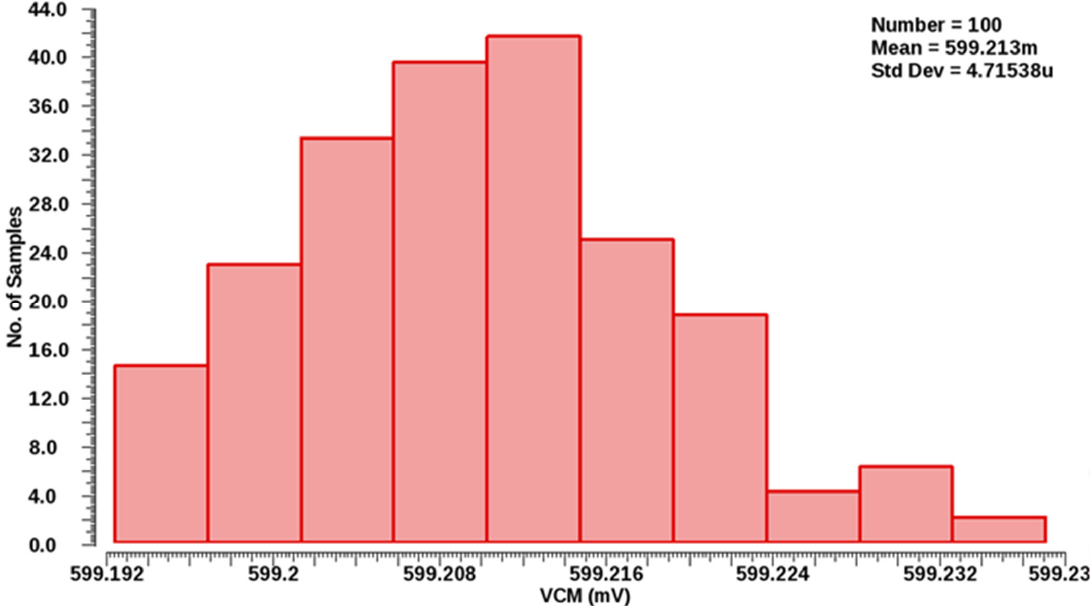
Figure 12. Monte Carlo simulation result of error amplifier-based bandgap reference voltage gener- ator.